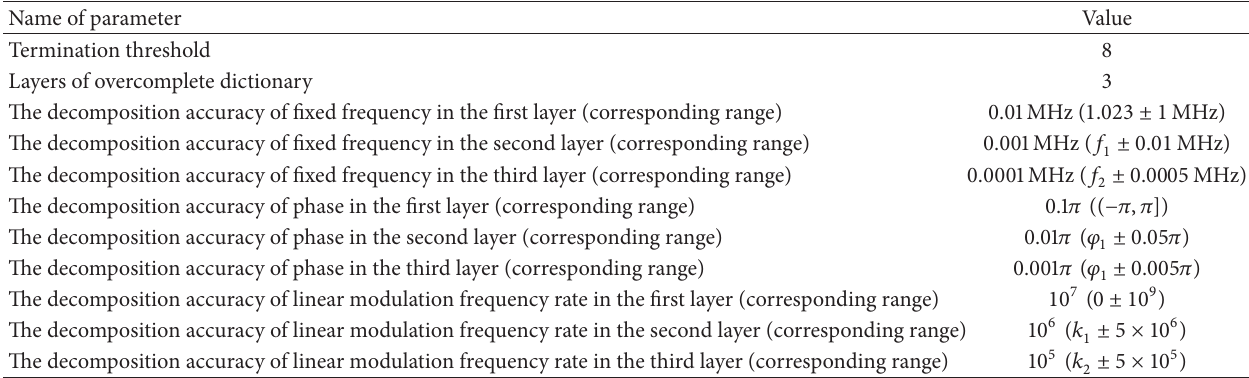
Table 2: The parameters involved in the proposed algorithm.